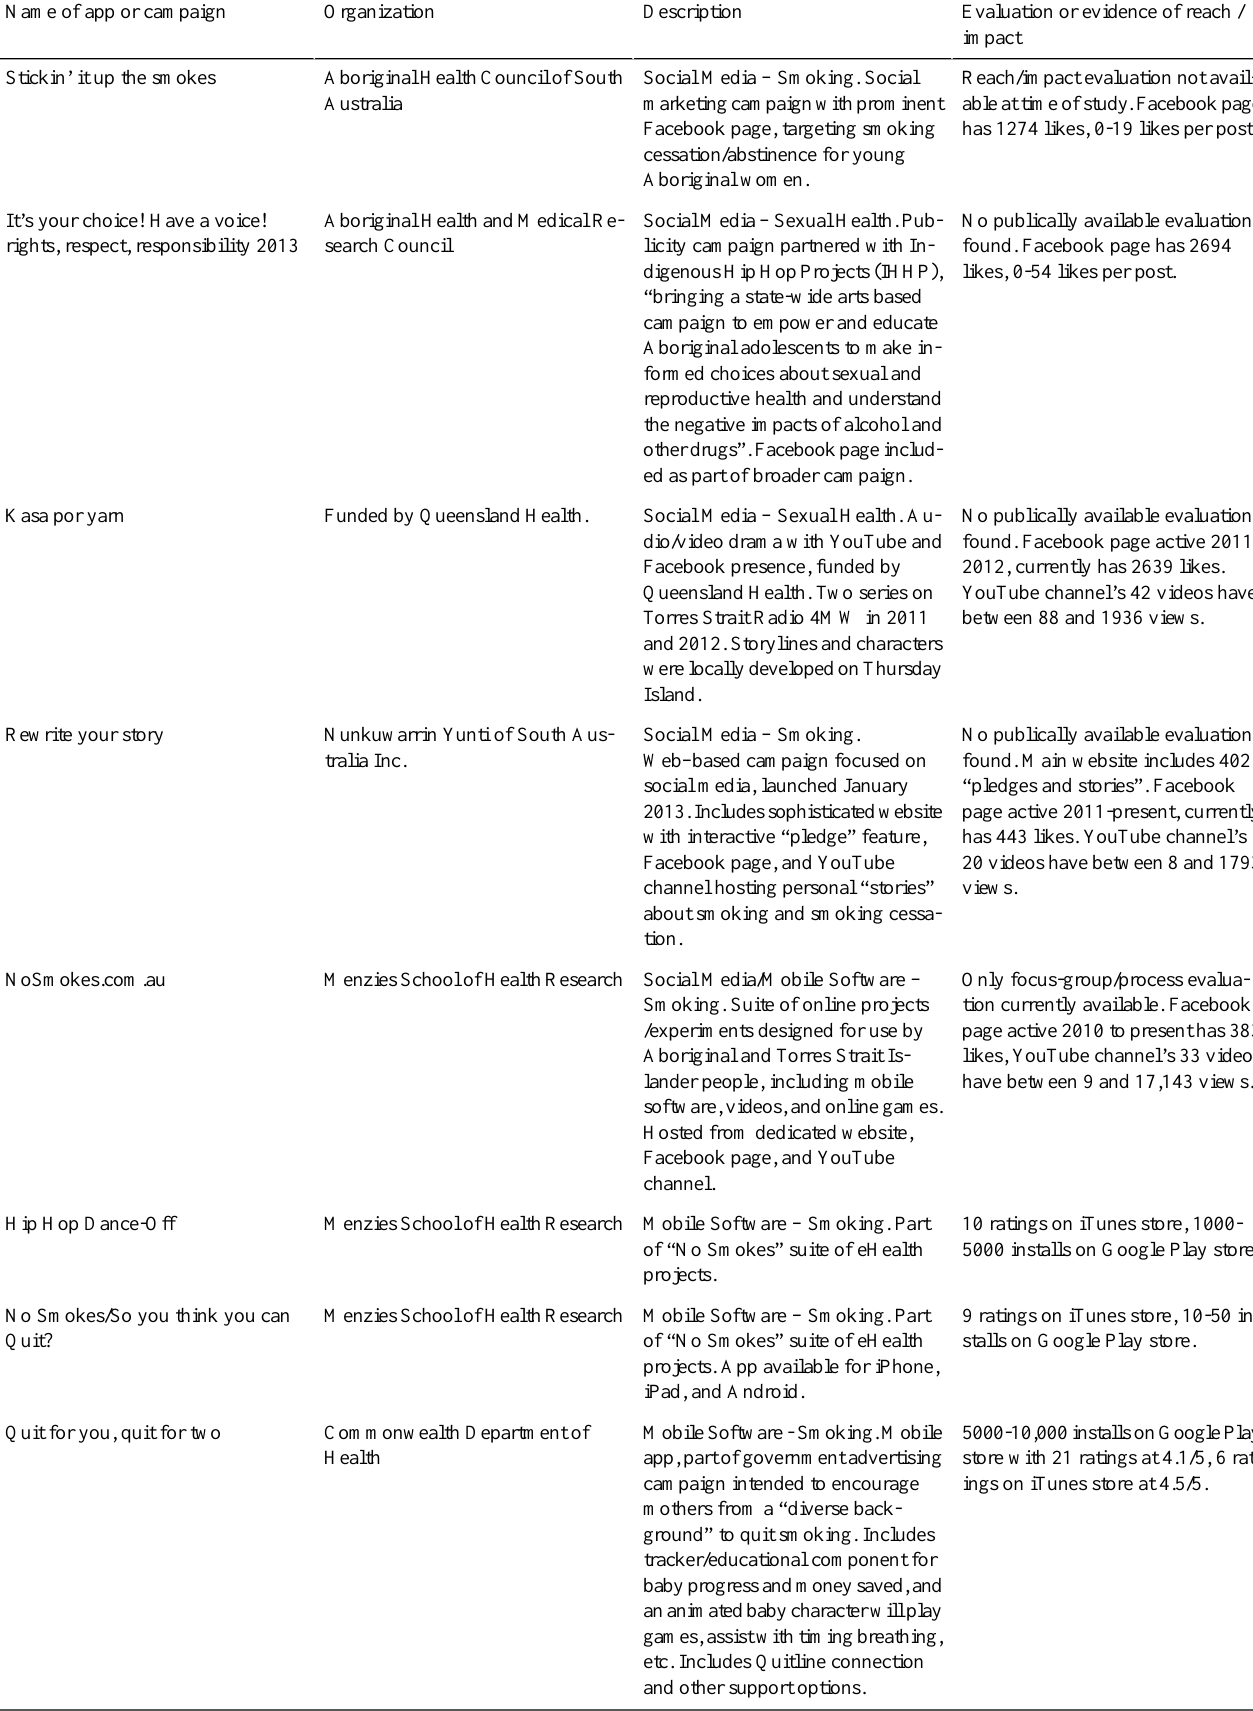
Table 4. Australian apps and social media programs with Indigenous